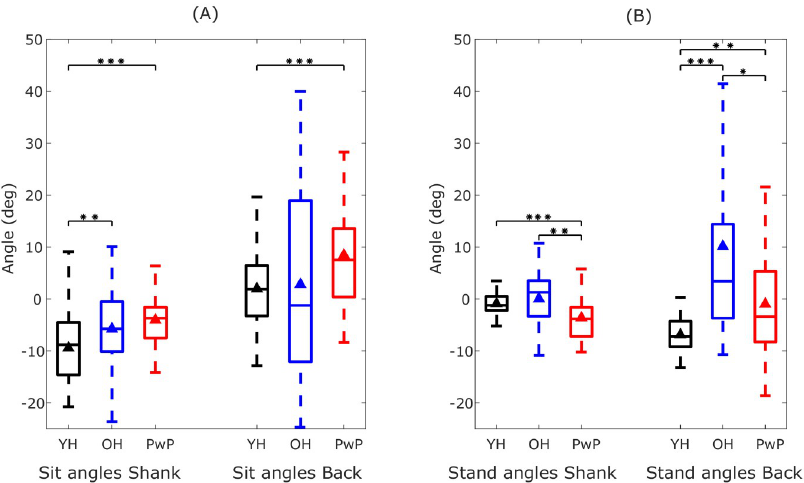
Fig 10. Variability in the posture during sitting and standing in the shank and back in younger healthy (YH) adults, older healthy (OH) adults and people with Parkinson’s (PwP). (A) The average angles of the shank and back in YH, OH and PwP participants during sitting. The black triangle shows the mean angle. (B) The average angles of the shank and back in YH, OH and PwP participants during standing. Statistically significant differences (Mann-Whitney U test with Bonferroni correction for multiple tests) in the angles of the shank and back among the three groups during sitting and standing are shown by the stars indicting the p-values (one star indicates p < 0.5, two stars indicate p < 0.01 and three stars indicate p <